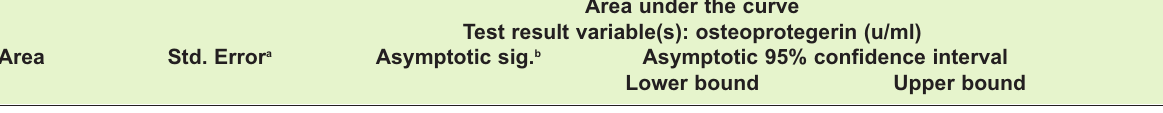
Receiver Operator Characteristic (ROC) curve of osteoprotegerin (u/ml) of cases Table III: Area under the